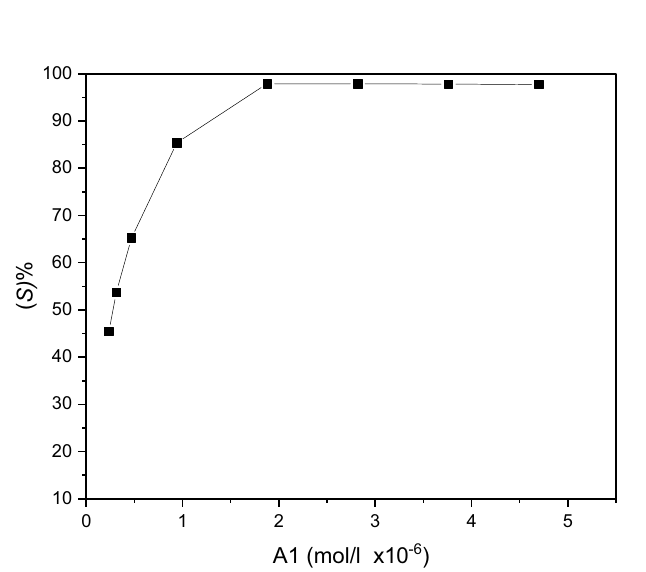
Figure 8. Influence of A1 concentration on the sublation efficiency of 1.0 × 10 −6 mol L −1 Pd (II) at pH 4.0